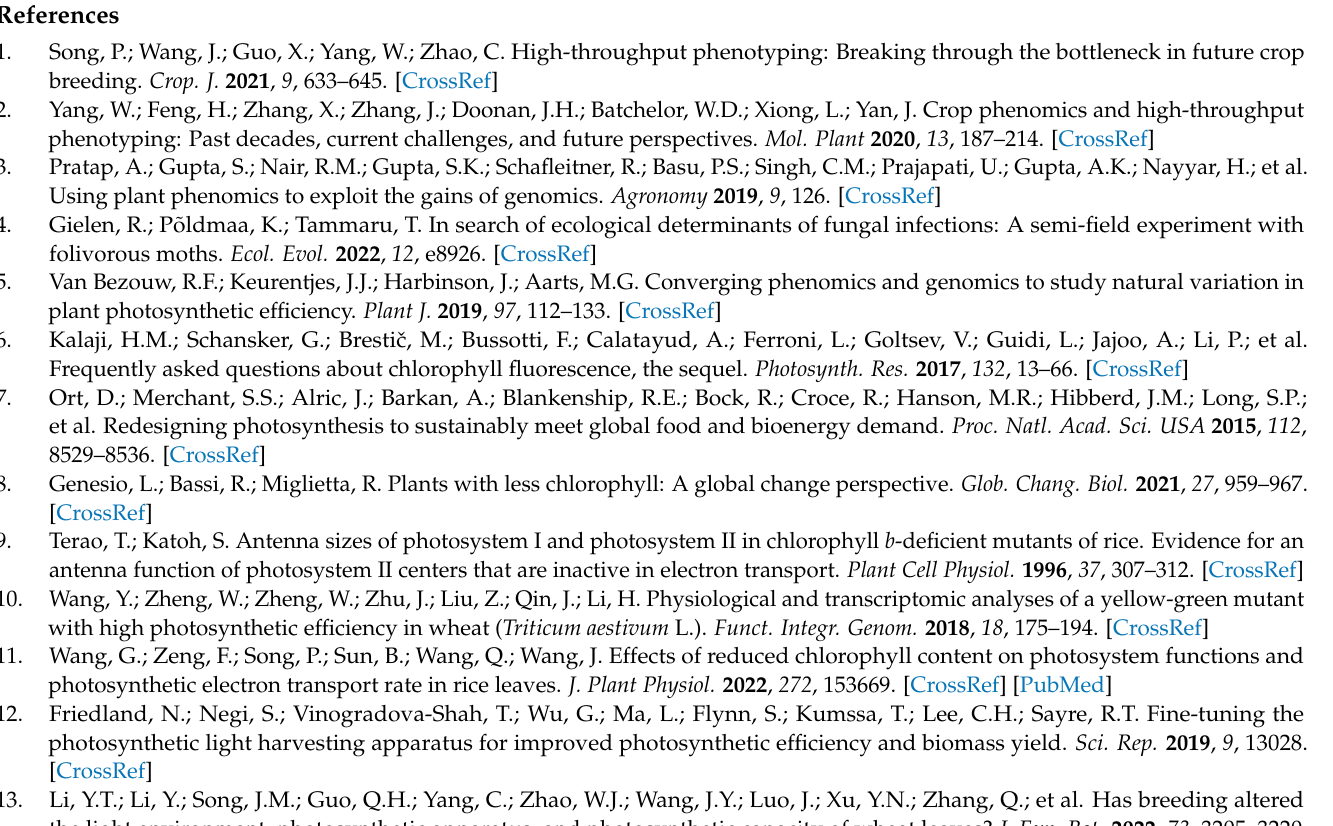
Figure A2. Example of a daily variation in solar radiation reaching the experimental site, as assessed on 20 November 2020, by the Meteorological Observatory of the Botanical Garden of Ferrara, Italy.